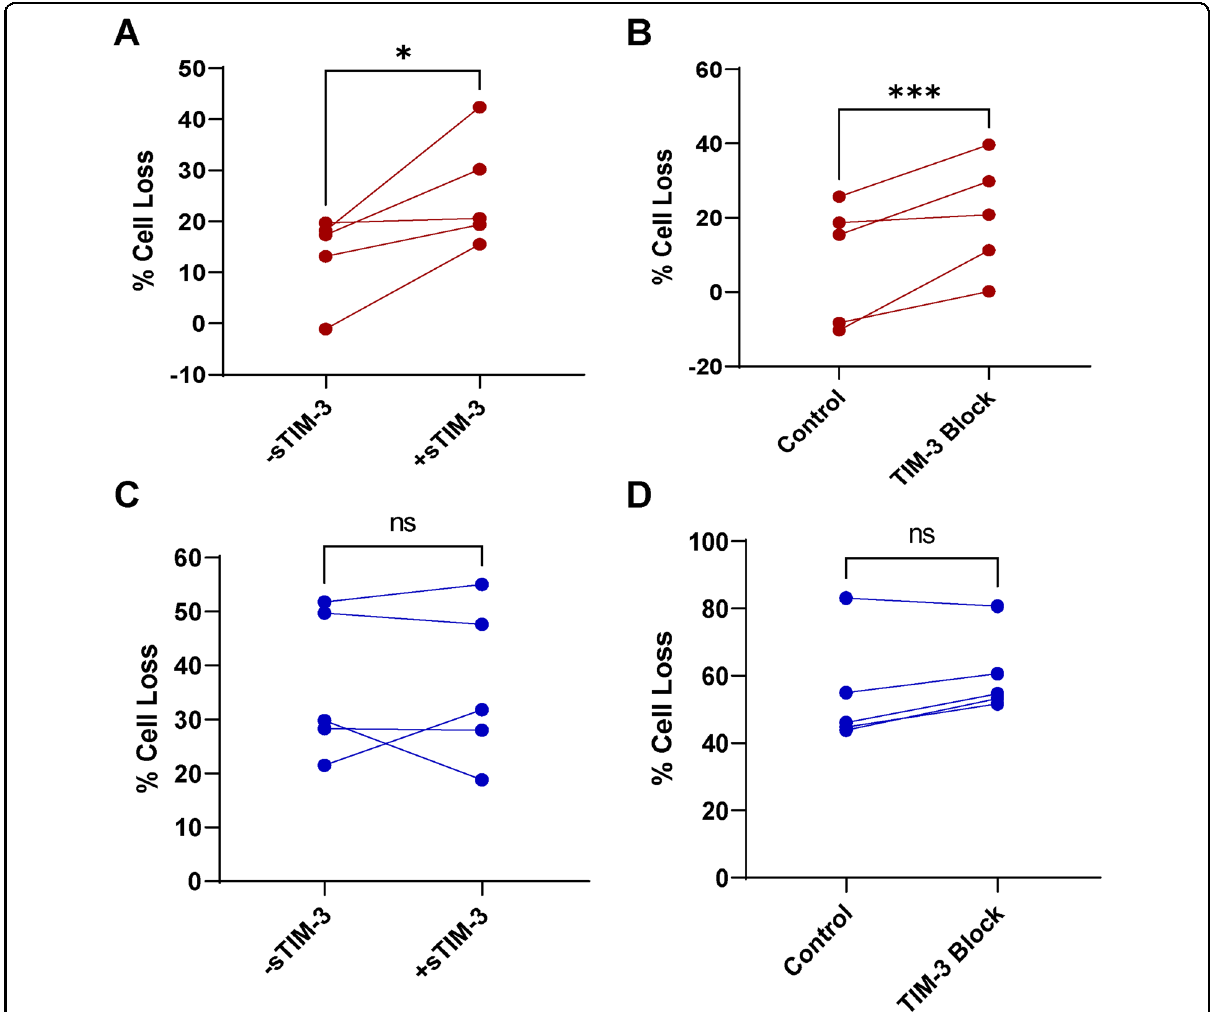
Fig. 4 TIM-3 ligand binding is required for mitigating RICD sensitivity in early stage effector T cells. Effector T cells at day 4 ( A ) or day 14 ( C ) were treated with soluble TIM-3 ( + sTIM-3) or isotype control (-sTIM-3) for 1 h prior to restimulation with 100 ng/mL of OKT3 and death assessment 24 h later. Cells were treated day 4 ( B ) or day 14 ( D ) with TIM-3 blocking antibody or an isotype antibody control for 1 h prior to restimulation with 100 ng/mL of OKT3 and death assessment 24 h later. Asterisks denote statistical signi fi cance using paired t tests: A p = 0.0399; B p = 0.0003; C p = 0.9957; D p =